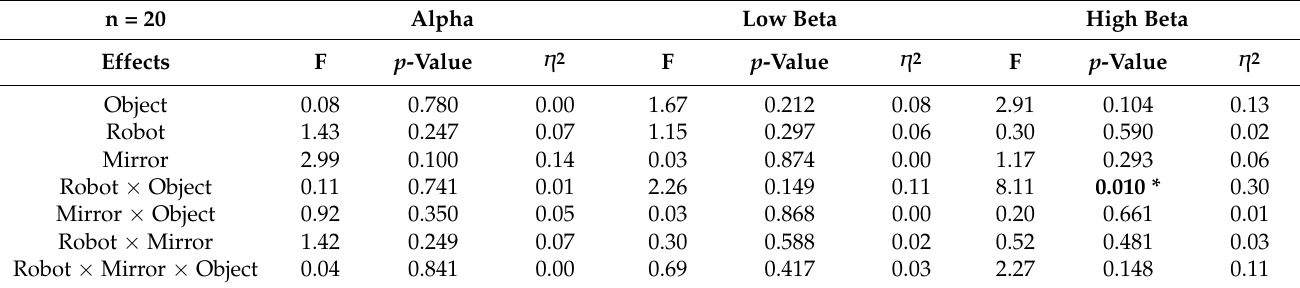
Table 3. Main effect analysis in the onset ≤ 1 year group. * p < 0.05.